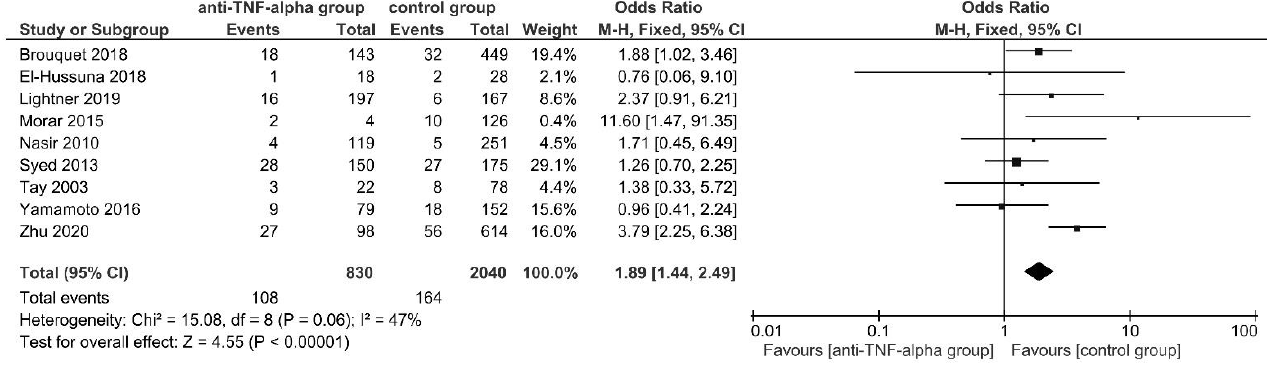
Figure 4. The fixed-effects model meta-analysis for 30-day postoperative intra-abdominal septic complications in the anti-TNF- α (intervention) and control group. Forest plot of all studies included.